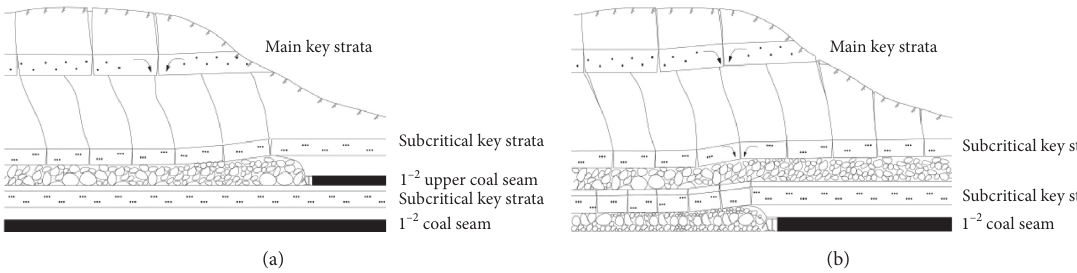
Figure 5: Breaking of the key stratum in downslope mining. (a) 1 − 2 upper coal seam. (b) 1 − 2 coal seam.